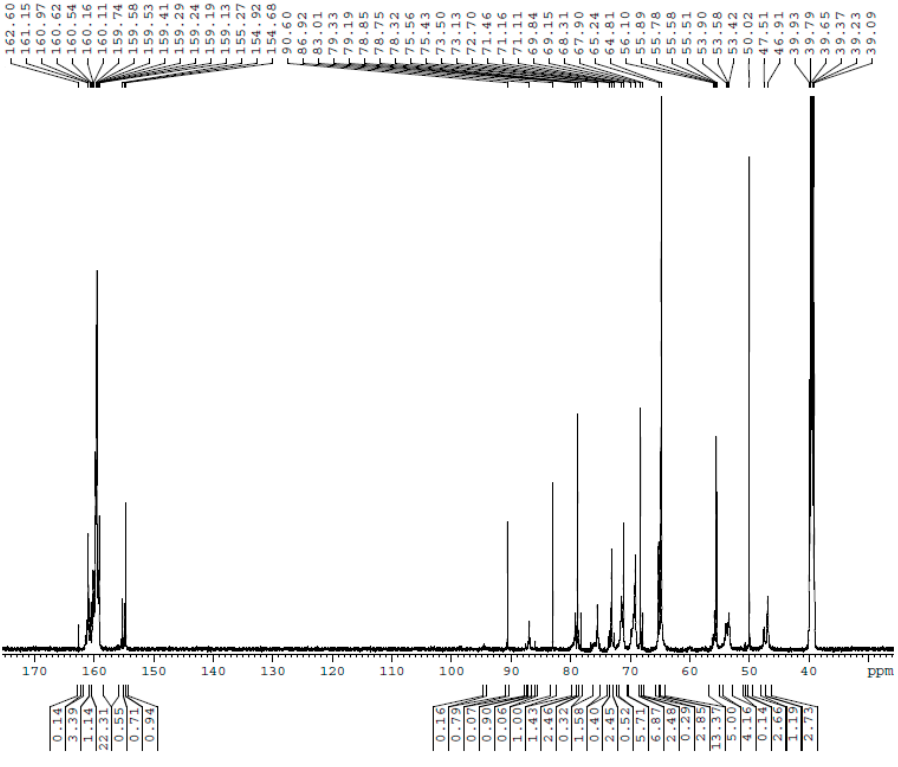
Figure 3. The 13 C NMR spectrum of sample UF-3.